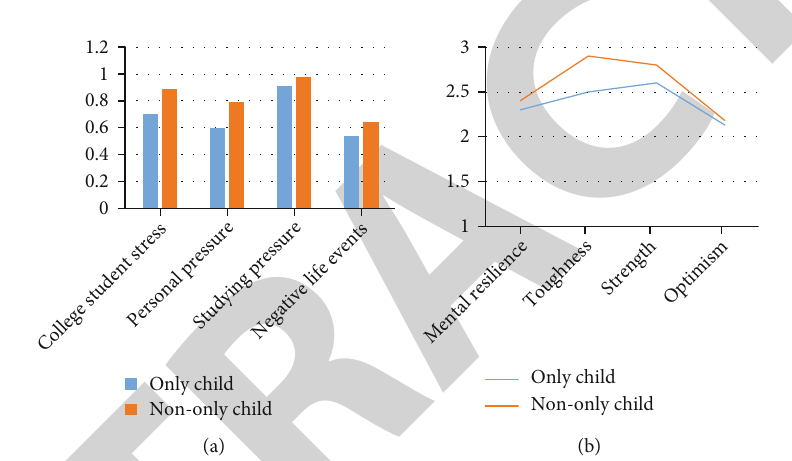
Figure 9: The test result of the di ff erence in psychological pressure and psychological fl exibility for nononly